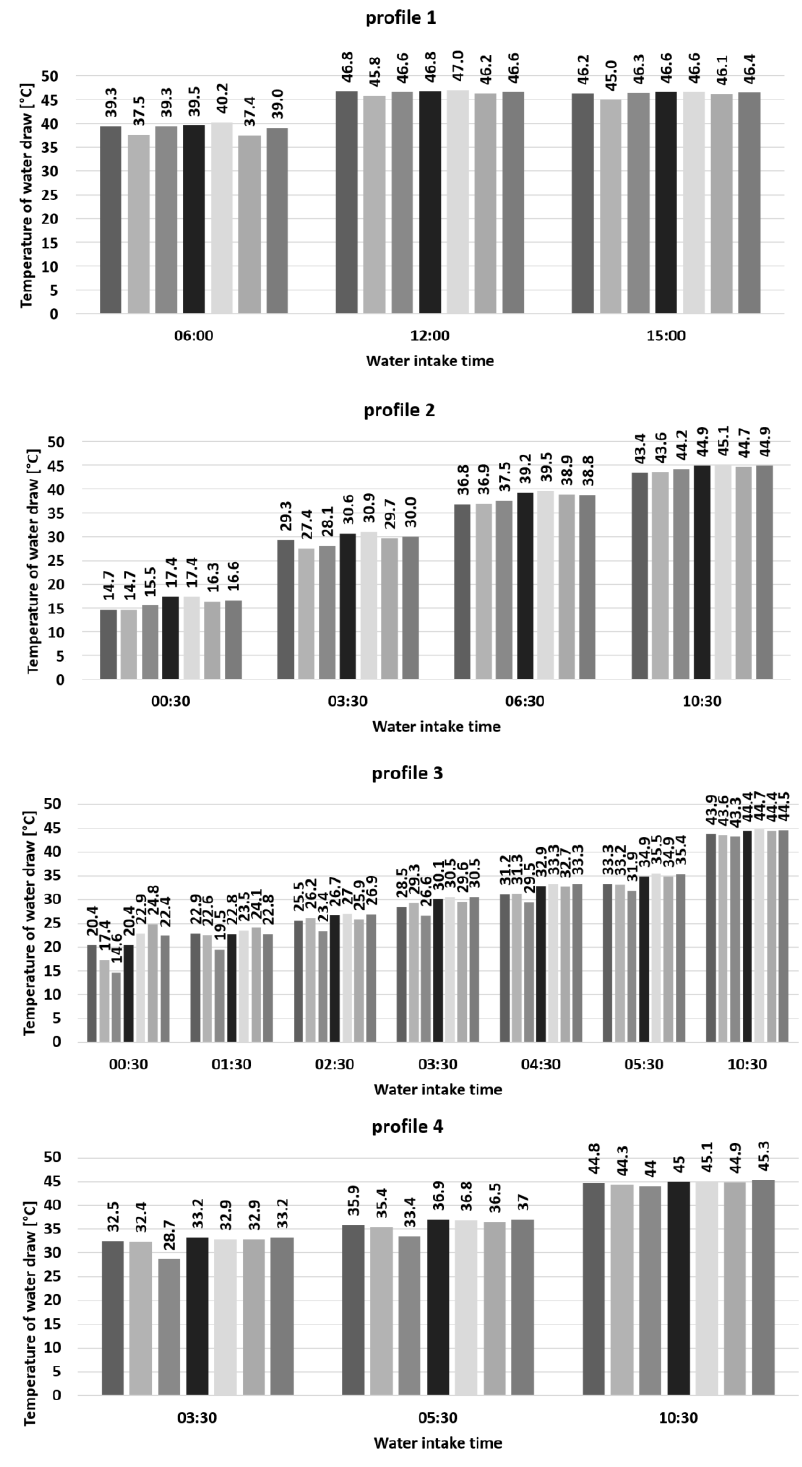
Figure 6. Temperature of water drawn from the tank ( T DHW_tank ).